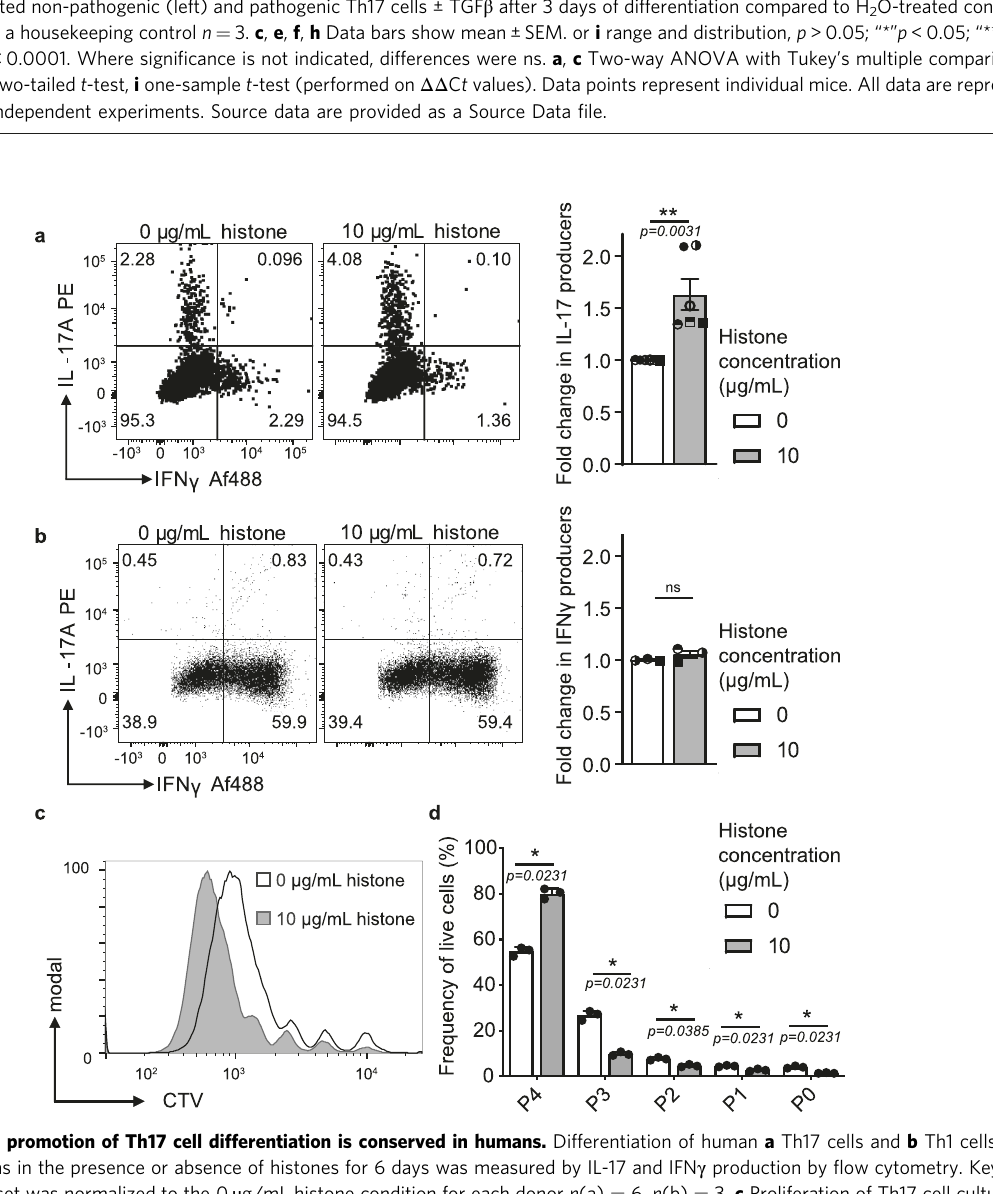
Fig. 3 Histones induce a Th17 cell-speci fi c response. a Mean expression levels of T cell activation markers after 16 h co-culture with 0 – 10 µ g/mL histone in the presence or absence (±) of α CD28 measured by fl ow cytometry n = 5. gMFI of each marker was normalized to the mean of no α CD28, 0 µ g/mL condition and heat map created from the mean of the normalized values. b Differentiation of mouse naive T cells into Th1, Th17, and Treg cells in the presence of histones was measured by fl ow cytometric quanti fi cation of the expression of key factors IFN γ , IL-17 and FOXP3 from total live cells. c Graphical representation of b at various concentrations of histones with expression levels normalized to expression levels in the absence of histones; Th17 10 µ g/mL histones n = 3, all others n = 4. d , e Frequency of cells expressing ROR γ t and f relative total ROR γ t expression at 32 h (calculated from the geometric mean) measured by fl ow cytometry n = 9. g , h Differentiation of mouse naive T cells into “ pathogenic ” Th17 cells with the addition of IL-23 in the presence of histones measured by fl ow cytometric quanti fi cation of IL-17 and GM-CSF after 5 days of culture n = 3. i Relative gene expression (fold- change) of histone-treated non-pathogenic (left) and pathogenic Th17 cells ± TGF β after 3 days of differentiation compared to H 2 O-treated controls. Hprt expression was used as a housekeeping control n = 3. c , e , f , h Data bars show mean ± SEM. or i range and distribution, p > 0.05; “ * ” p < 0.05; “ ** ” p < 0.01; “